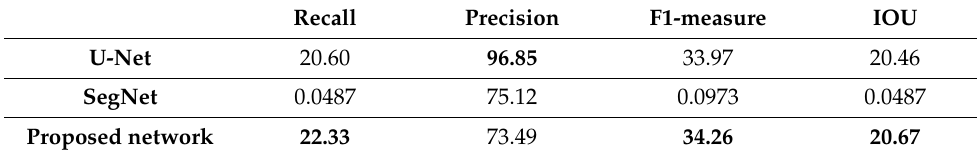
Table 2. Evaluation statistics (%) in landslide detection from Lushan study area.